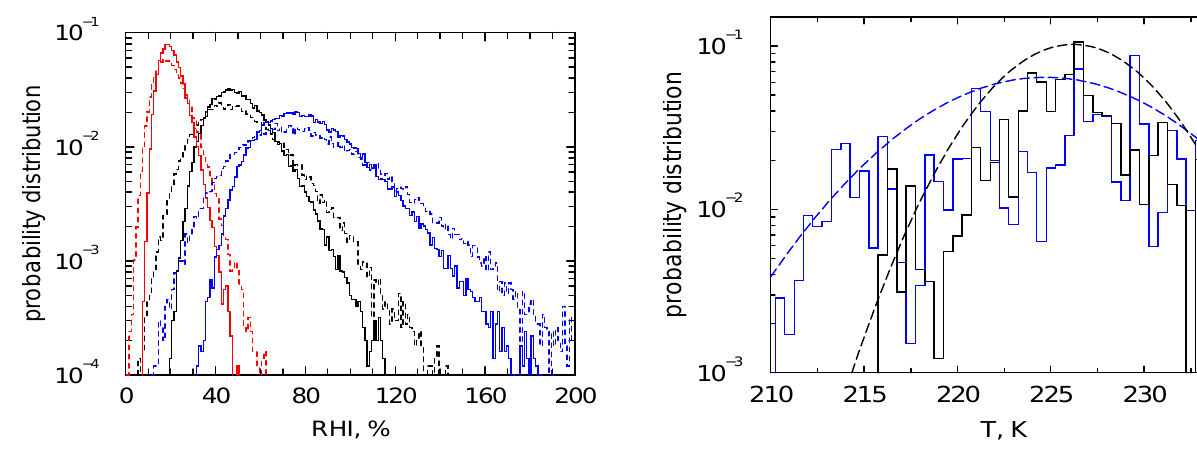
Fig. 5. Probability distributions of T measured during the INCA experiment (Prestwick, black curves; Punta Arenas, blue curves). The stair steps represent the discretized in situ data. The number of data points is 59,444 (Punta) and 50,412 (Prestwick). The dashed curves are normal distributions evaluated with mean temperatures and standard variations obtained from the respective data